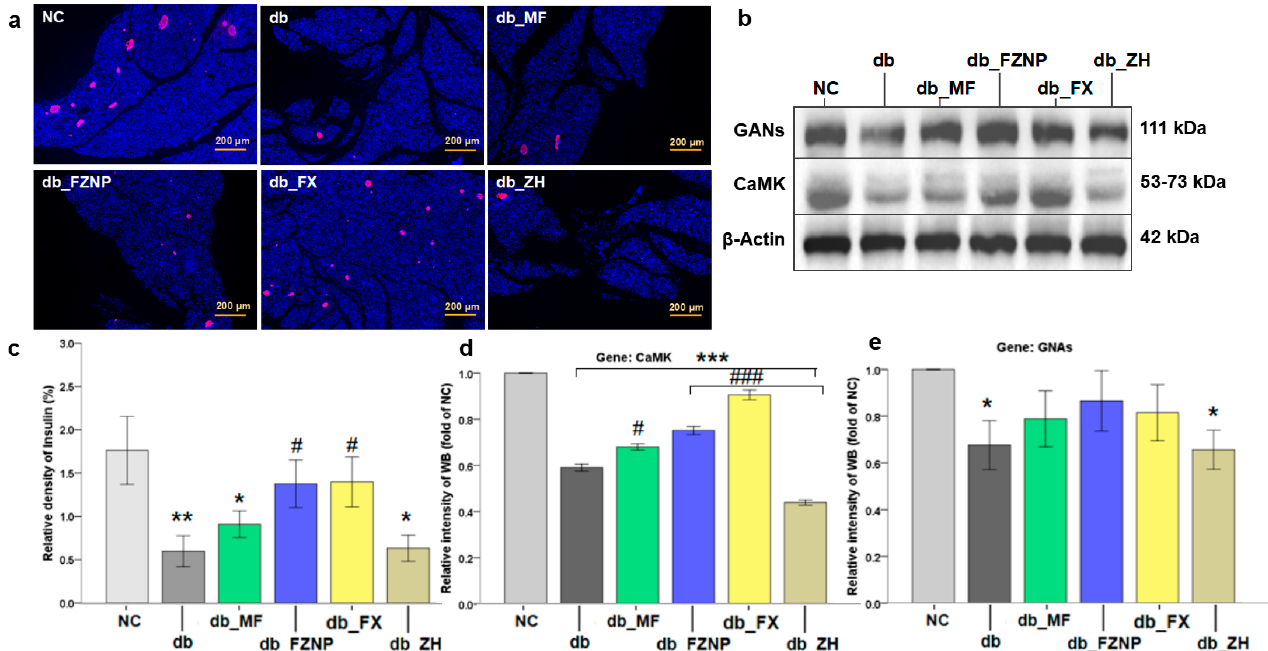
Figure 5. Testing of insulin and protein expression in the pancreas. Pancreatic tissue was analyzed by immunofluorescence. Insulin-positive cells were shown to fluoresce in pink and nuclei were stained with DAPI (blue fluorescence) to observe the fluorescence intensity of insulin-positive areas ( a ). The intensity of each sample was quantified using ImageJ software ( b ). Western blot images of GNAs, CaMK and β actin expression ( c ). The analysis of ImageJ for CaMK ( d ) and GNAs ( e ) expression. The asterisk including * ( p < 0.05), ** ( p ≤ 0.01), and *** ( p ≤ 0.001) indicate the significant difference compared with the NC group. The hashes including # ( p < 0.05) and ### ( p ≤ 0.001) indicate the significant difference from the db group.